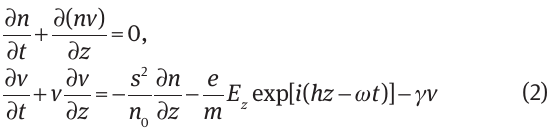
, where i = 1 i = ε , v is the drift velocity 3 m 0